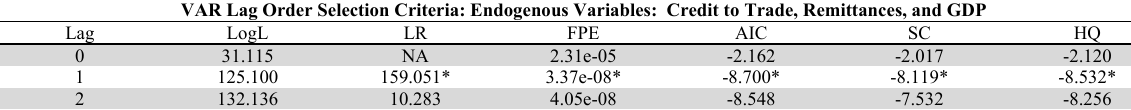
VAR Lag Order Criteria